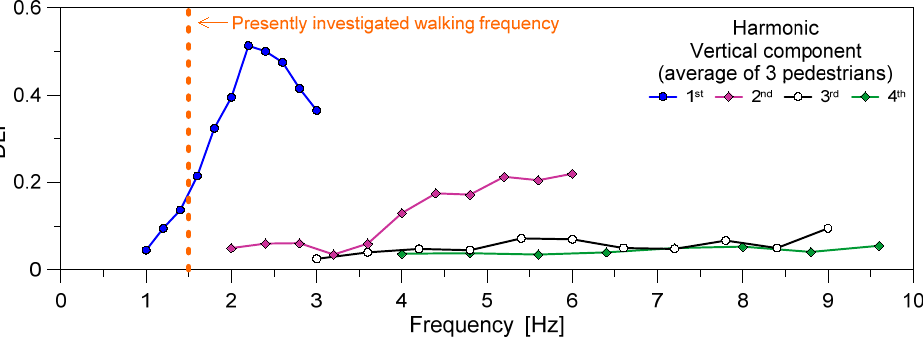
Figure 2. Experimental derivation of DLF values from comparative data discussed in [7], in the form of average measurements for three pedestrians walking in the range f p = 1÷3 Hz. In evidence, the presently explored walking frequency ( f p = 1.5 Hz).